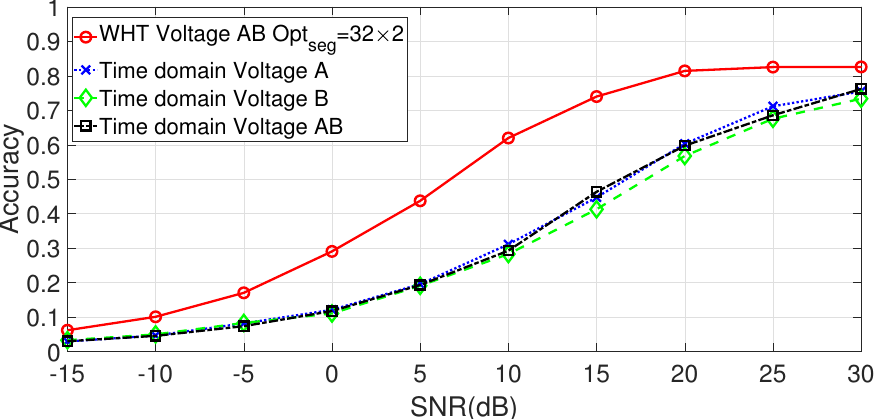
Figure 9. Comparison of the approach based on CNN with WHT and Opt seg = 32 ∗ 2 (Voltage A and B), and CNN with the original time domain voltage signal for Voltage A, B, and the combination of Voltage A and B for different values of SNR in dB.